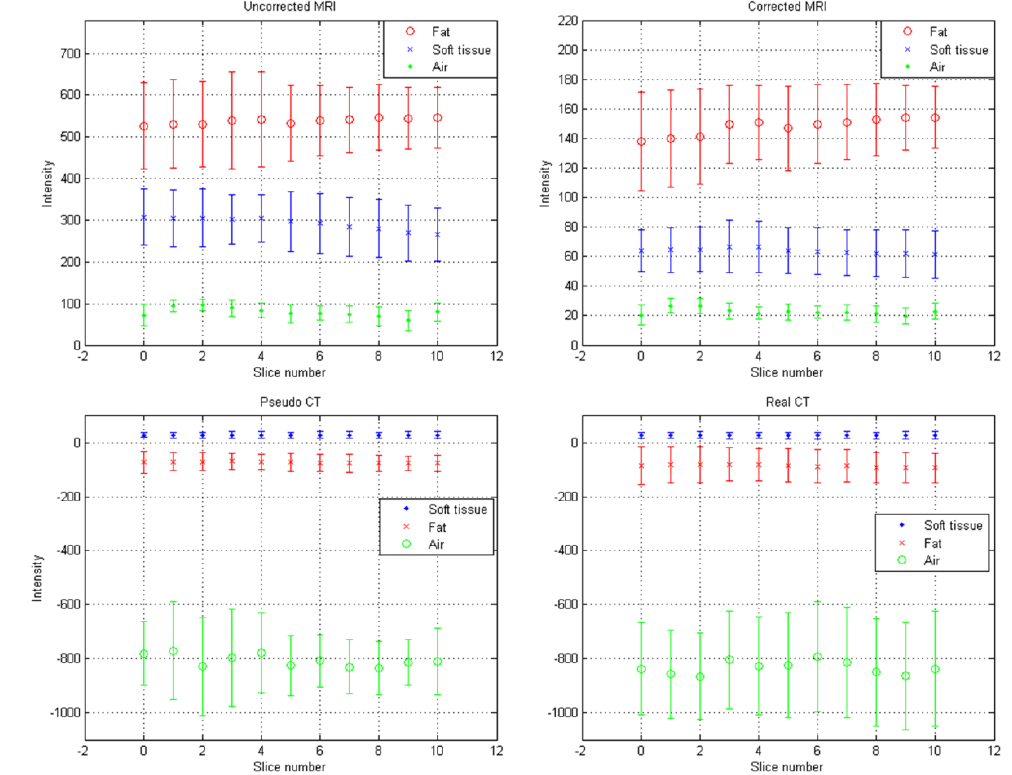
Figure 12. Mean (central marker) and standard deviation (error bar) of abdominal imaging for lesion diagnosis: ( a ) uncorrected MRI, ( b ) corrected MRI, ( c ) pseudo-CT, and ( d ) real CT.